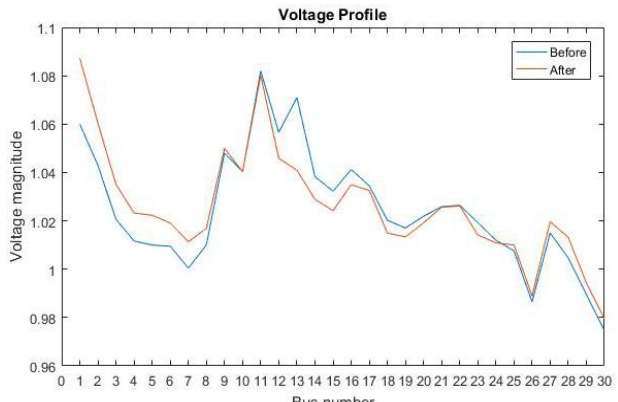
Figure 3. Voltage magnitude at each bus before and after CM (Case 1)